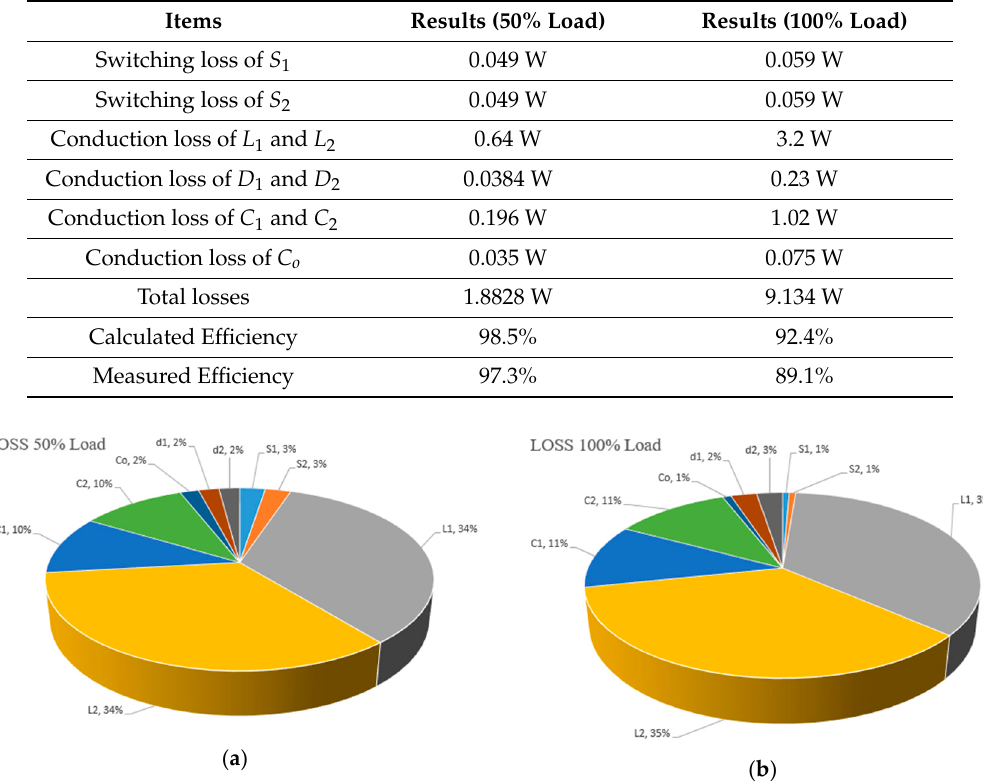
Figure 21. The losses breakdown charts. ( a ) half load and ( b ) rated load conditions.